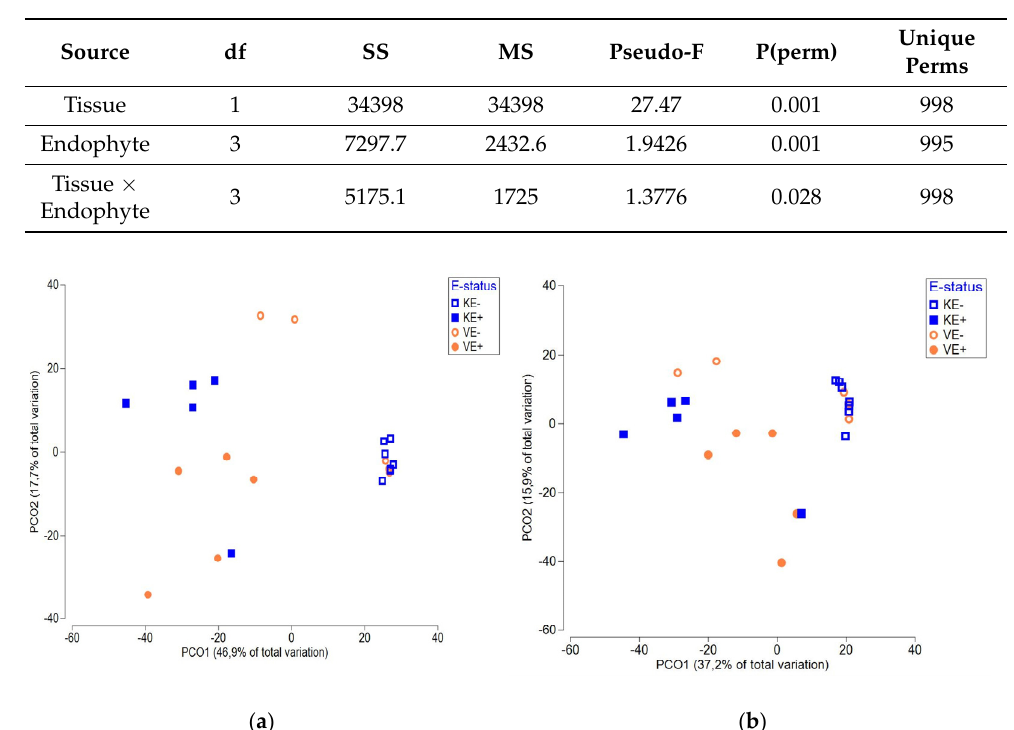
Figure 3. PCoA analysis on ( a ) total endophytic fungal communities and ( b ) Epichloë -depleted fungal communities in ‘Kasper’ Epichloë -symbiotic (KE+), ‘Kasper’ Epichloë -free (KE-), ‘Valtteri’ Epichloë -symbiotic (VE+) and ‘Valtteri’ Epichloë -free (VE-) leaves of meadow fescue (Festuca pratensis) as indicated by the Epichloë -status (E-status) in the figure.